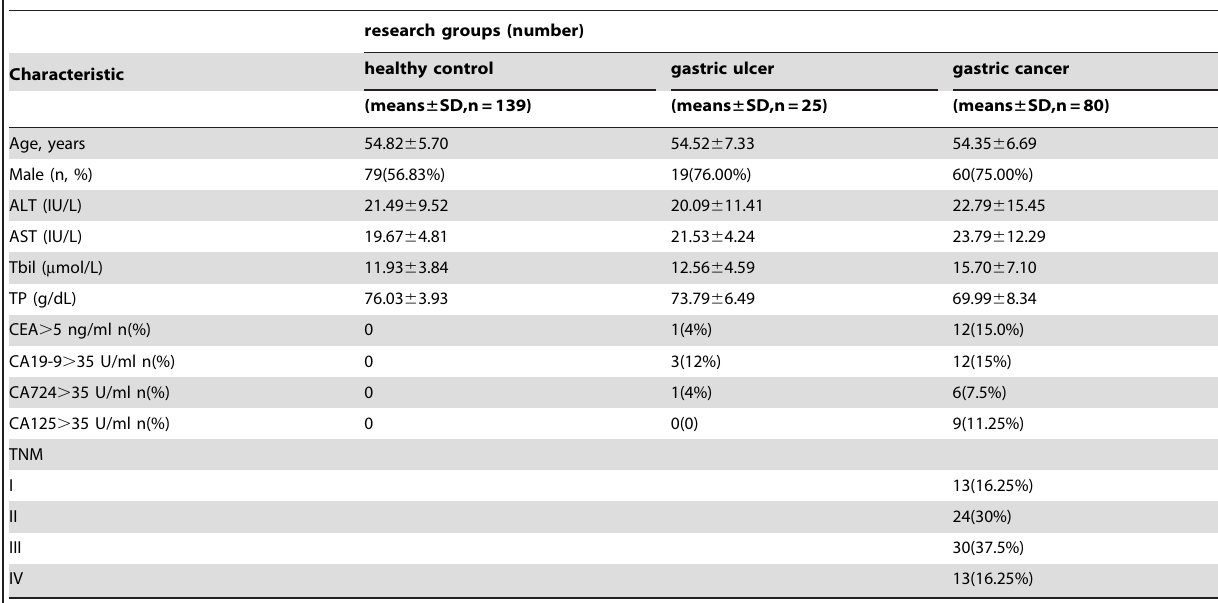
Table 1. Demographic and clinical characteristics of subjects in research